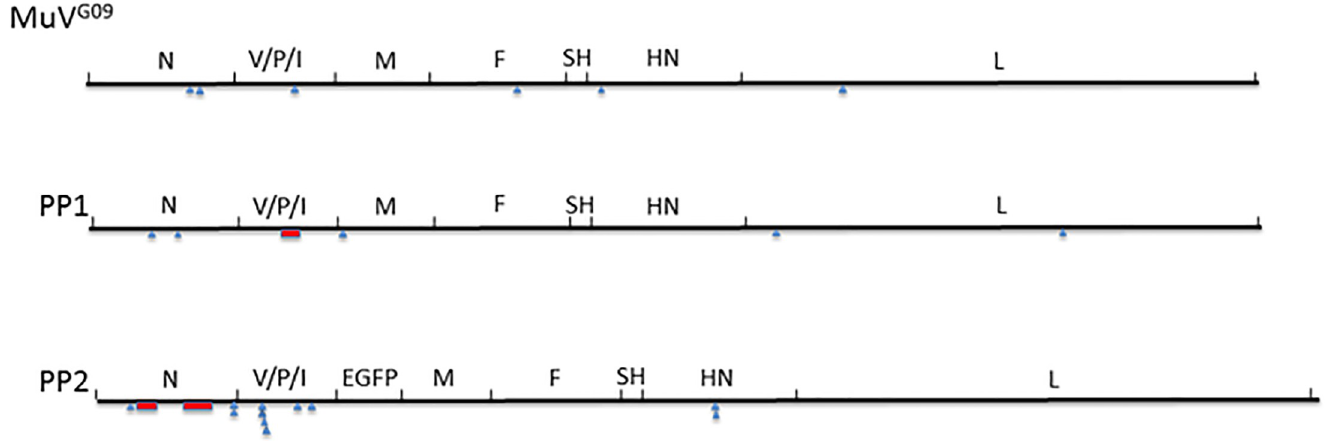
Fig 3. Genome distribution of mutations occurring during passage. The position of new mutants observed after six passages of MuV G09 and PP1 on Vero cells and PP2 virus on B-LCL cells. Red boxes indicate the position of the clusters of mutations in the genomes of PP1 and PP2 virus; blue triangles show the genome positions of the mutants identified in Table